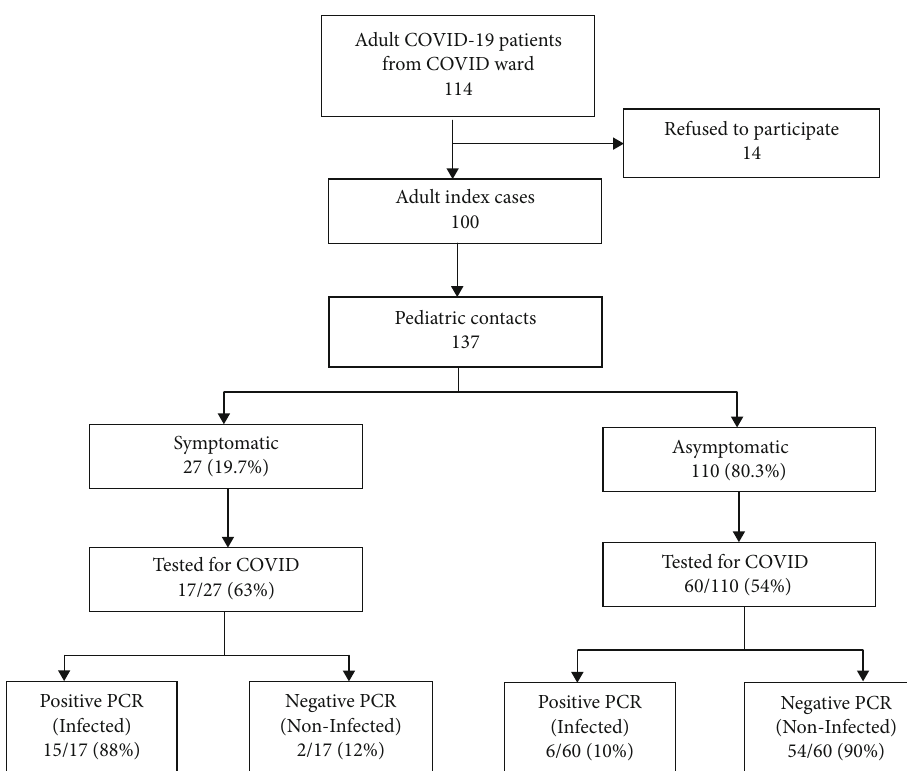
Figure 1: Flow chart of involved contacts and their course of